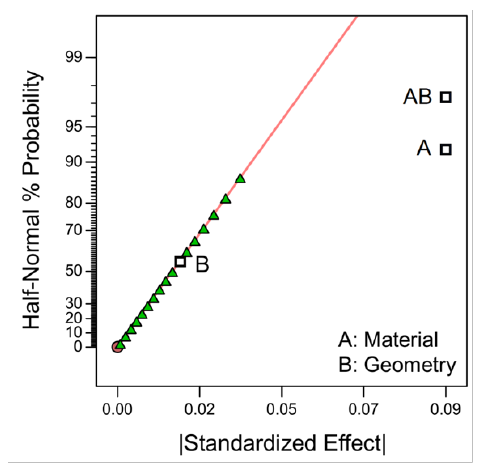
Figure 6. Normal probability plot for: ( a ) Young’s modulus; ( b ) ultimate tensile strength; ( c ) flexural strength; and ( d ) interlaminar shear strength.